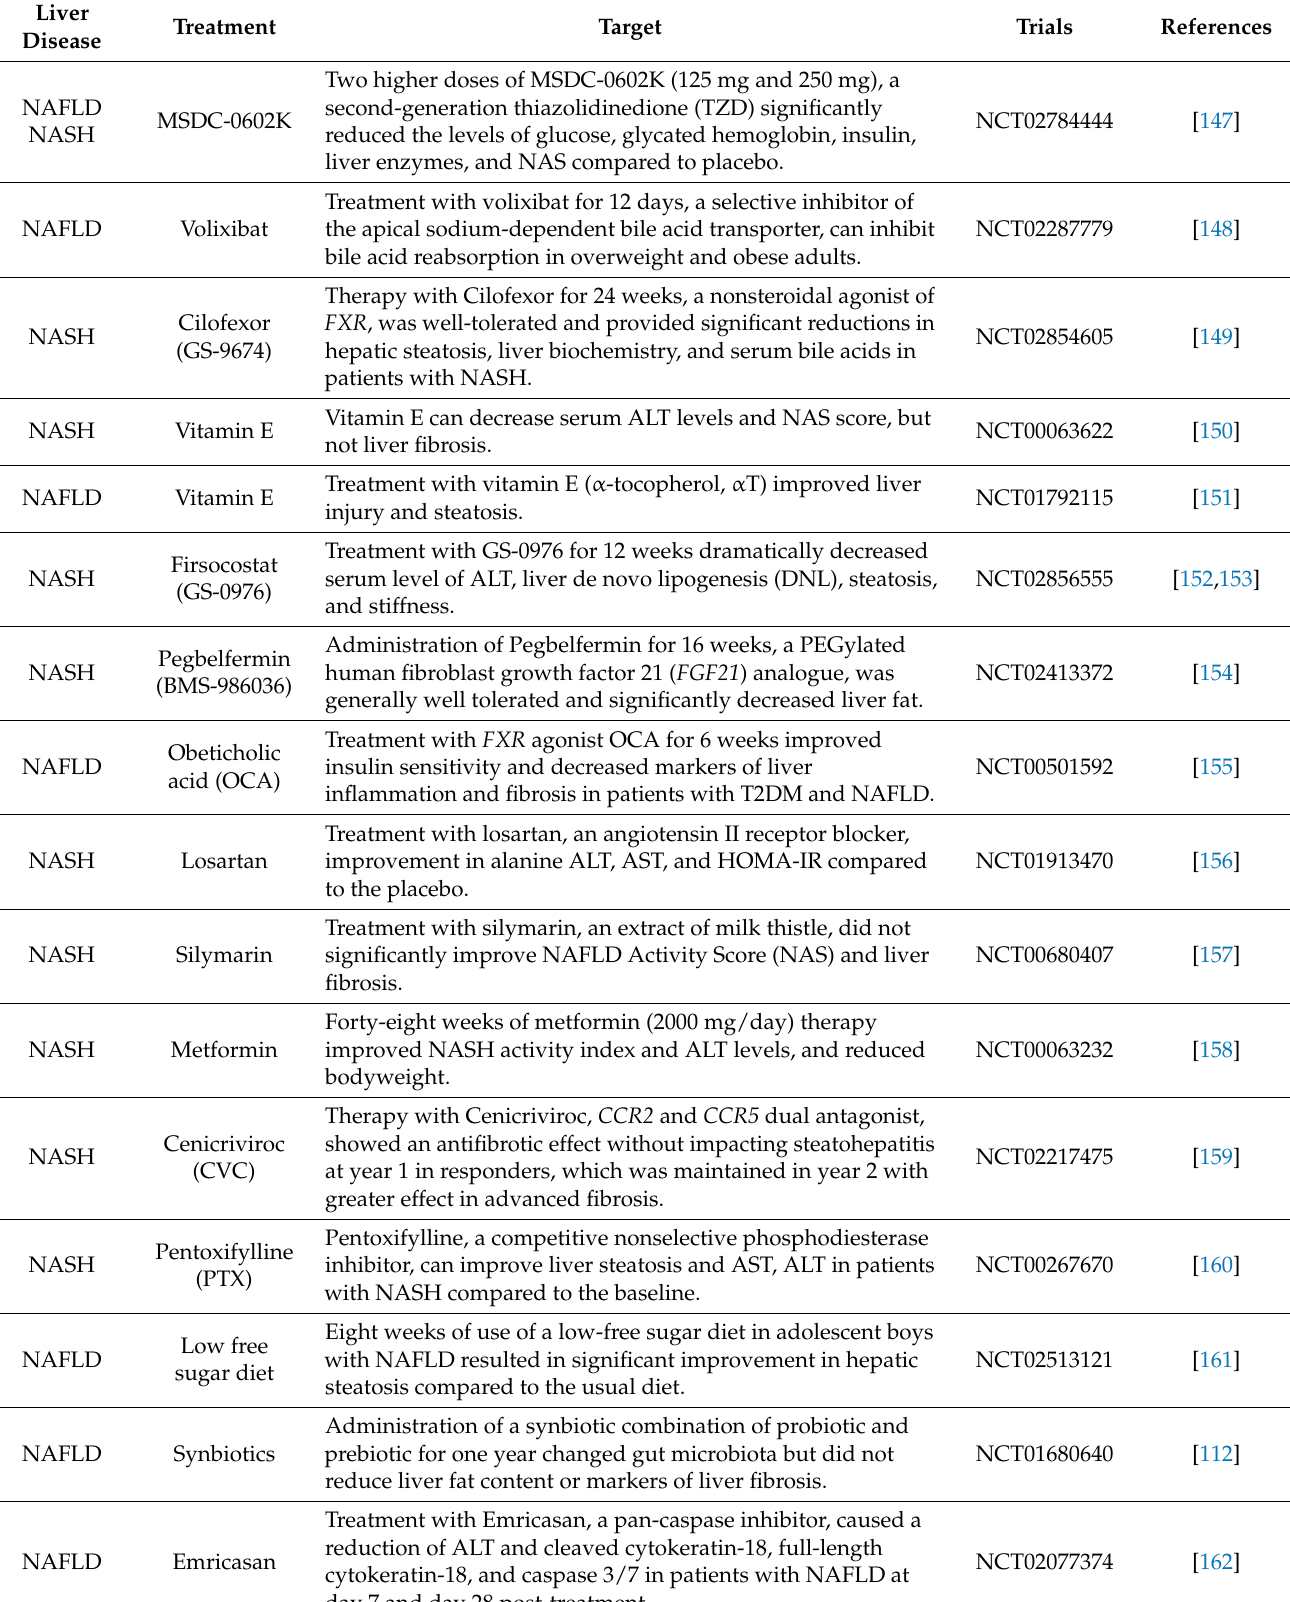
Table 3. The completed clinical trials for NAFLD/NASH